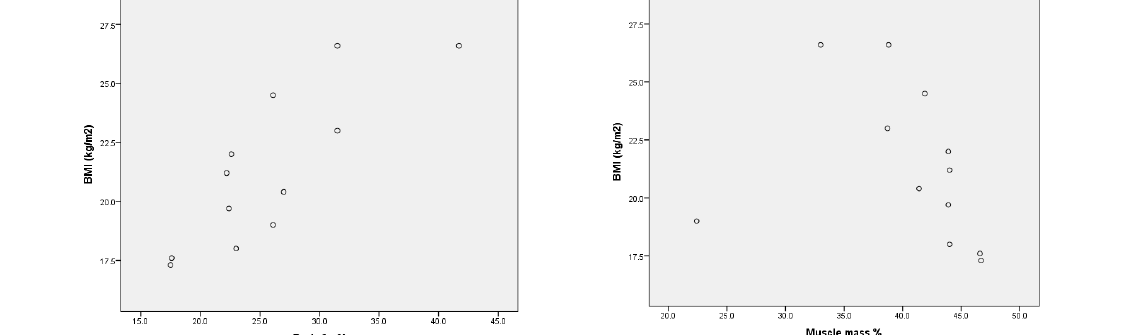
Graph 1. Correlation between BMI and body fat % for the group of boys with SID